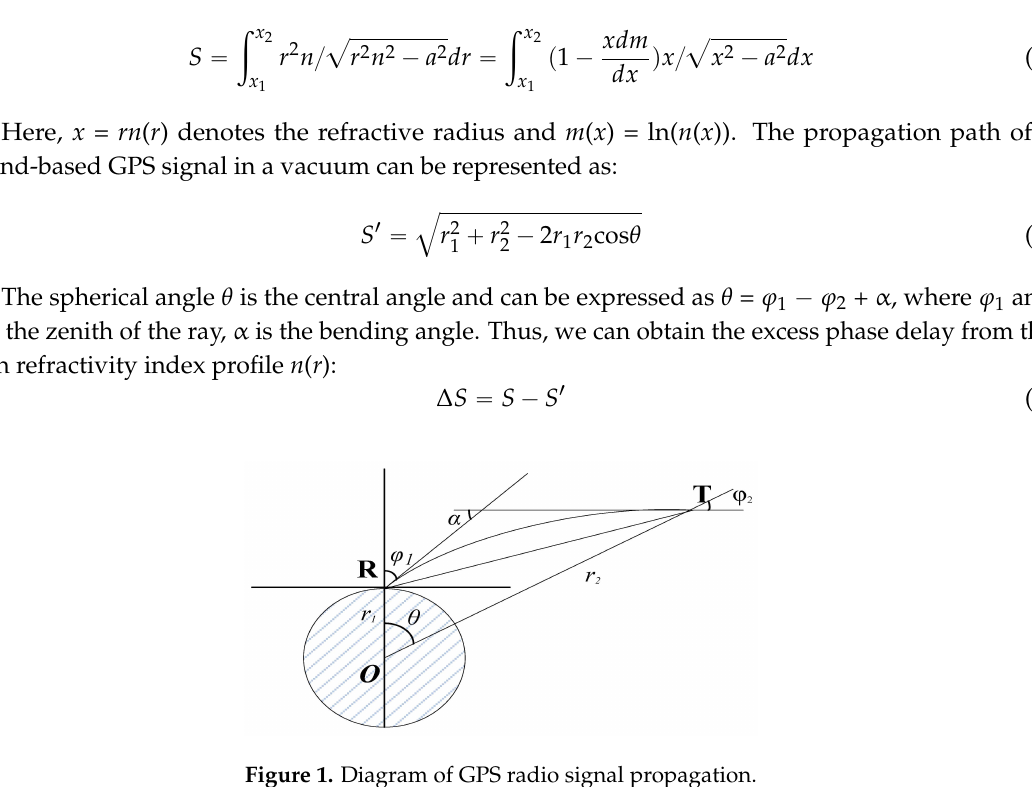
Figure 1. Diagram of GPS radio signal